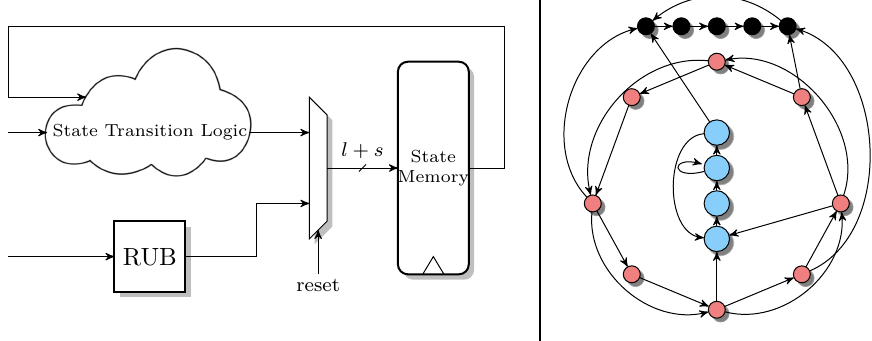
Figure 6: Active Hardware Metering technique example. The RUB response determines the initial state of the FSM. The enabling key then determines the transition from the obfuscation mode states (marked in red) to the original initial state of the FSM (marked in